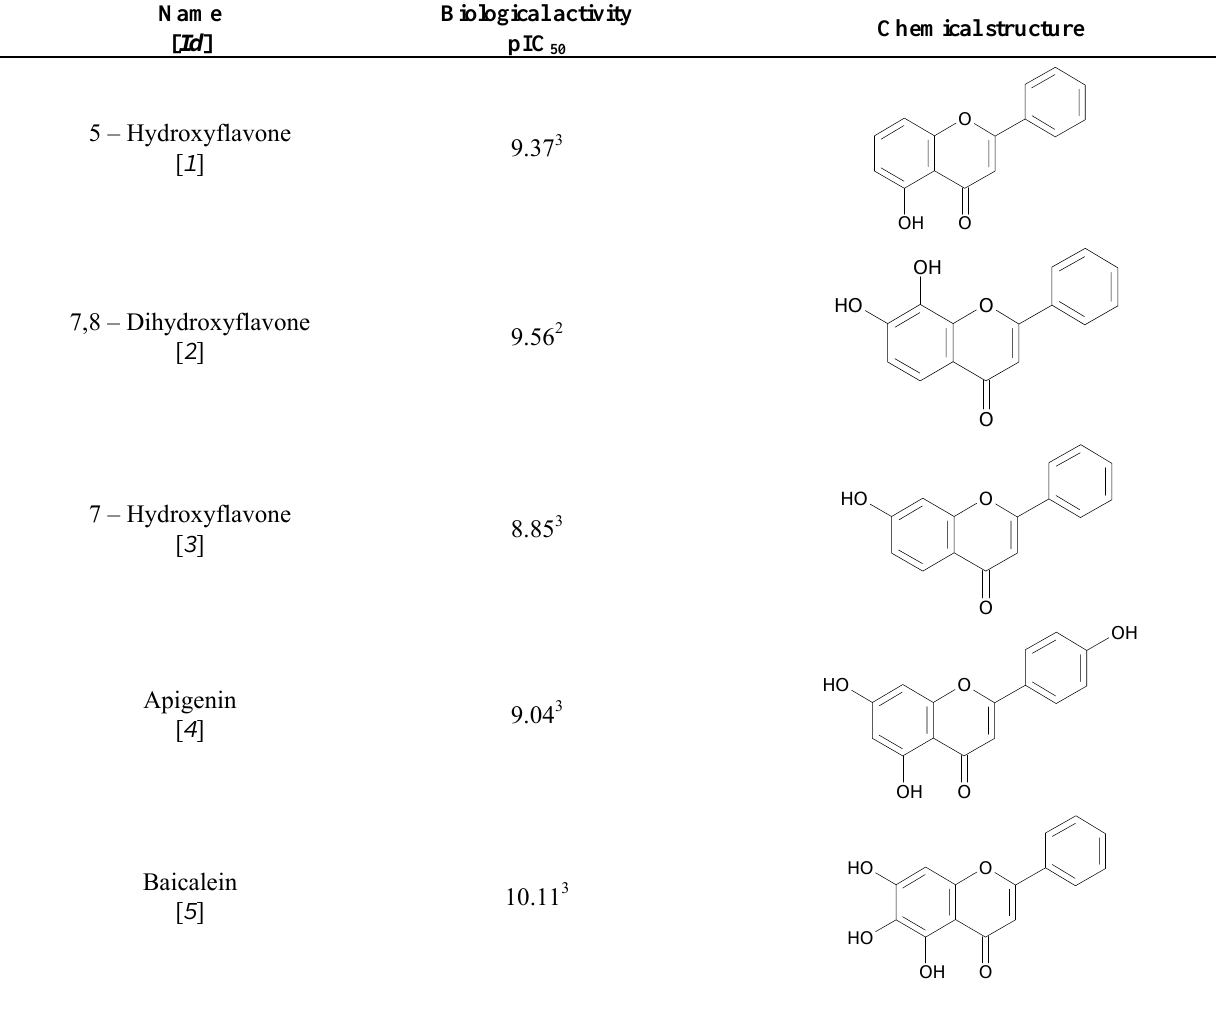
Table 1. Structures and biological activities of the forty investigated compounds.